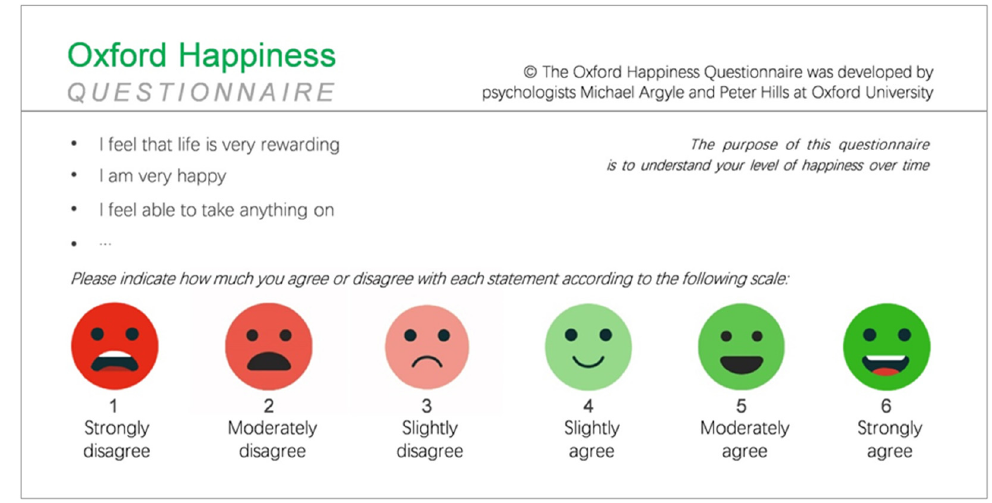
Figure 2. Oxford Happiness Questionnaire.